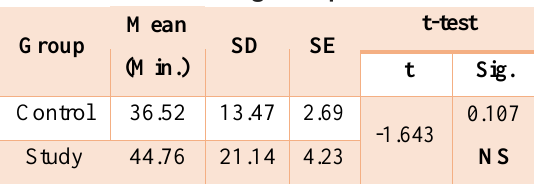
Table 2: Mean of surgical operation time .